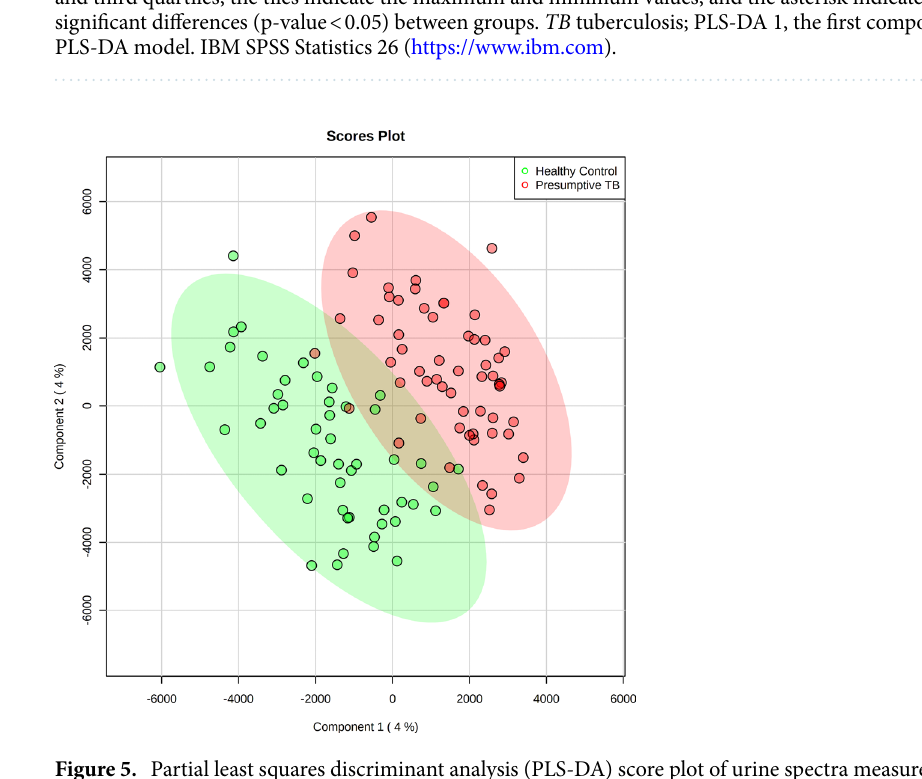
Figure 5. Partial least squares discriminant analysis (PLS-DA) score plot of urine spectra measured using low-field proton (1H) nuclear magnetic resonance spectroscopy of children with presumptive TB (n = 56) and healthy children (n = 53). Two-dimensional view showing the distribution of the groups according to the first two components of the PLS-DA model. TB, tuberculosis. Metaboanalyst 5.0. (https:// www. metab oanal yst.